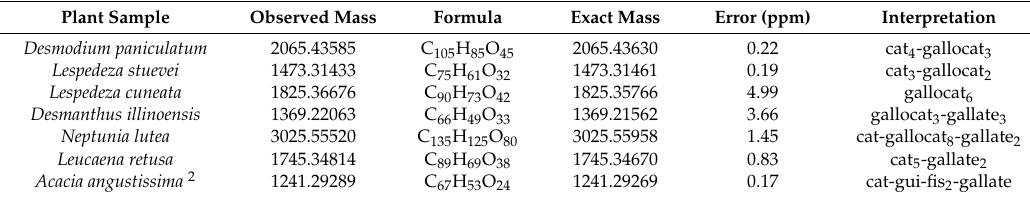
Table 4. Selected MALDI signals and their exact assignments. The polymers comprise the flavan-3-ol subunits (epi)catechin (cat), (epi)gallocatechin (gallocat); the 5-deoxy flavan-3-ol subunits guibourtinidol (gui), fisetinidol (fis) and, in some cases, gallate esters (gallate) 1 .